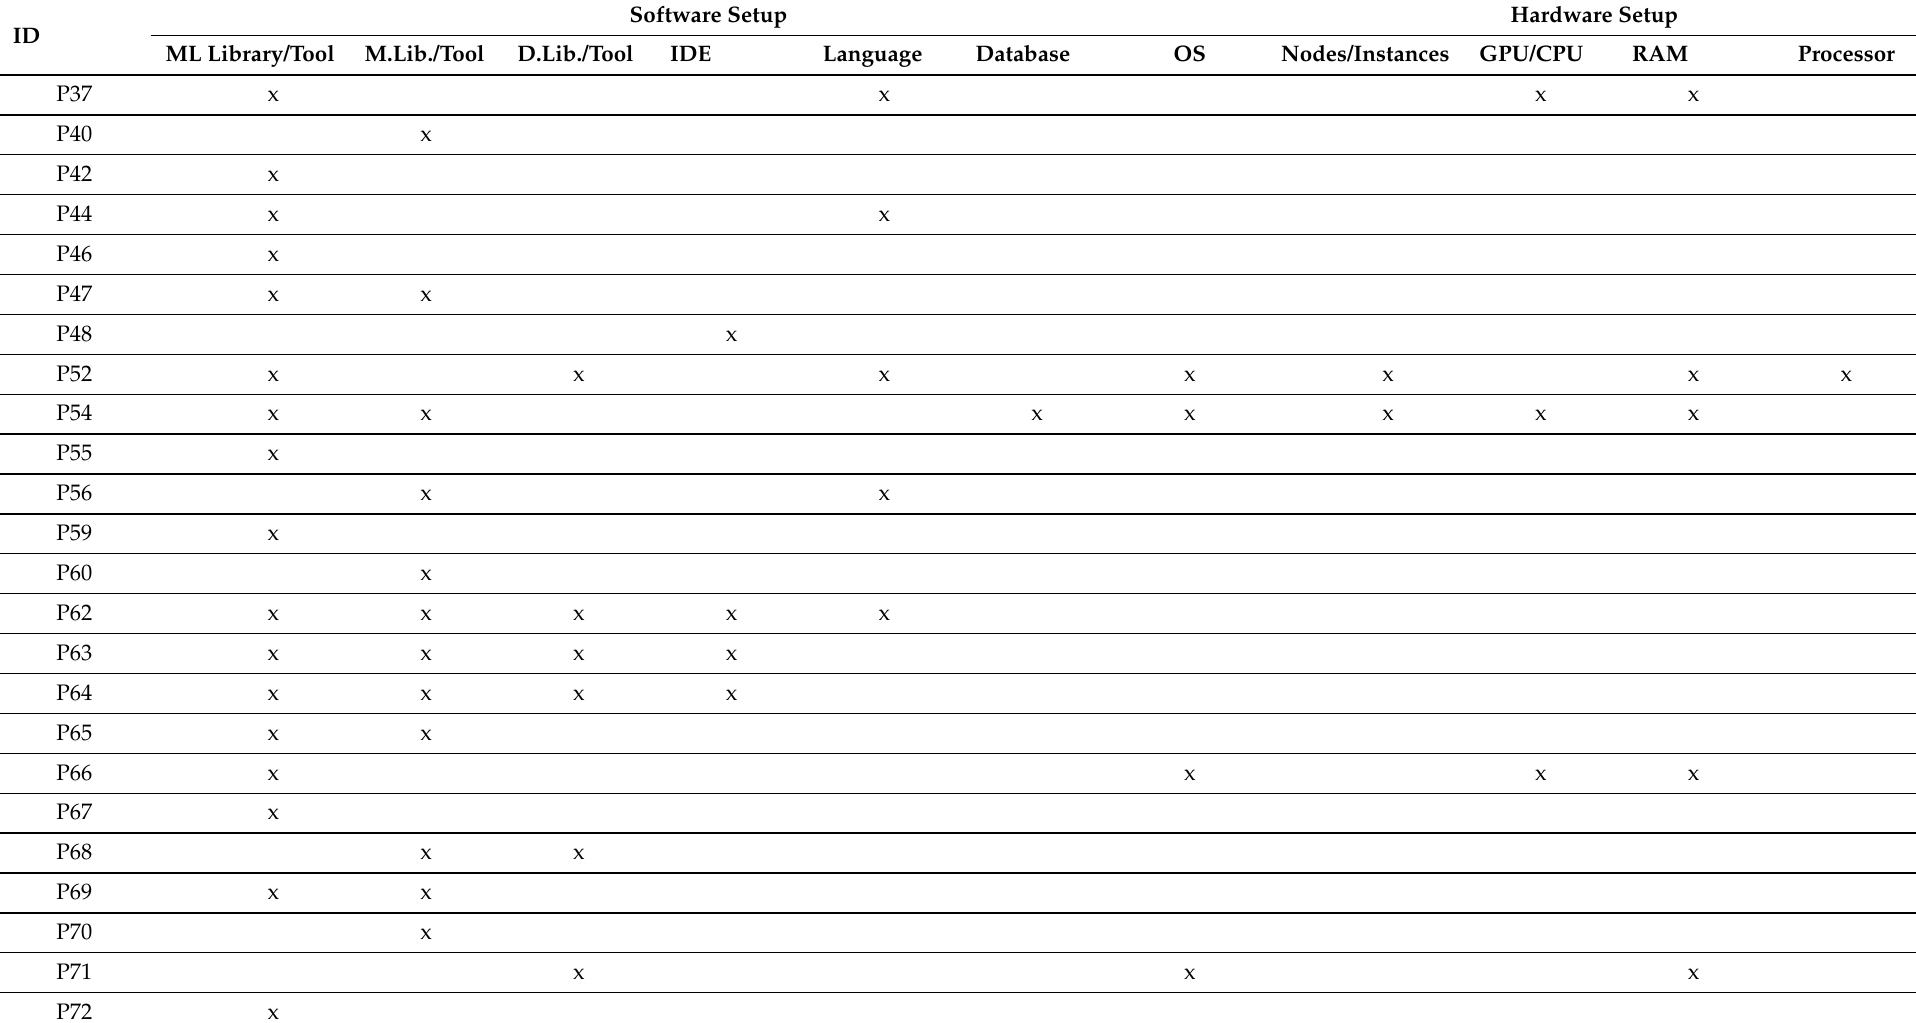
Table A3. Articles indicating software and hardware